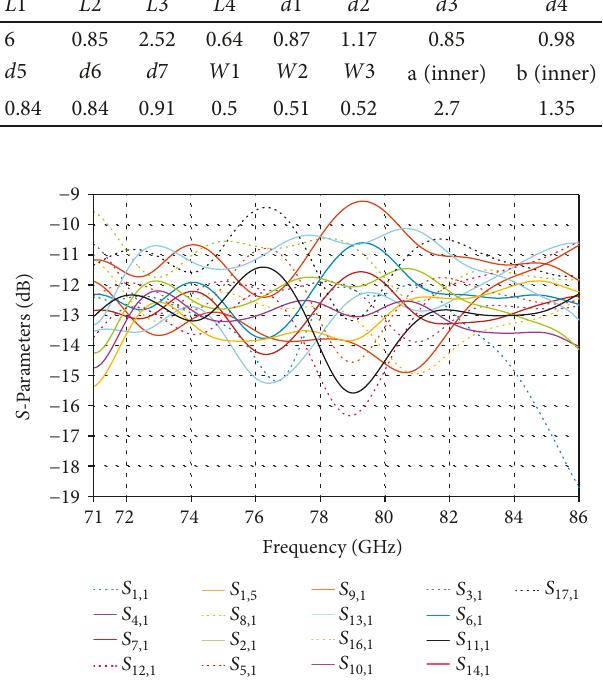
Figure 5: Simulated S -parameters of the waveguide feed